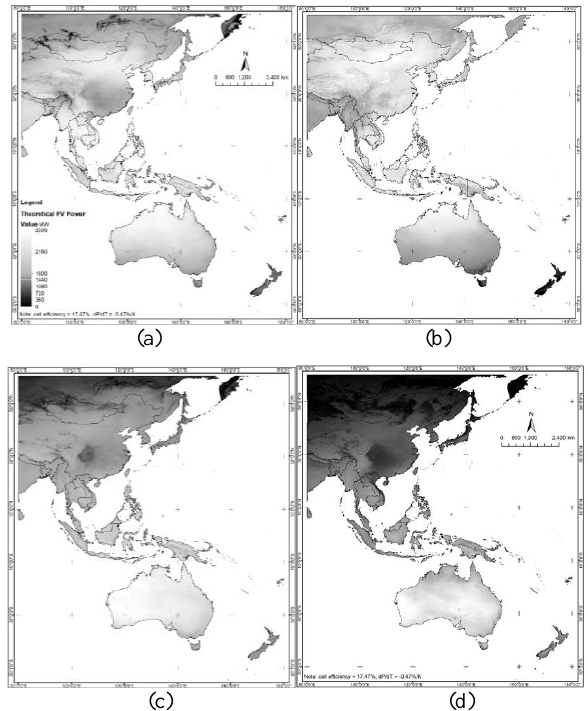
Figure 2. Theoretical mean seasonal solar PV power (in megawatts) in the Asia Pacific region: (a) MAM; (b) JJA; (c) SON; (d) DJF.